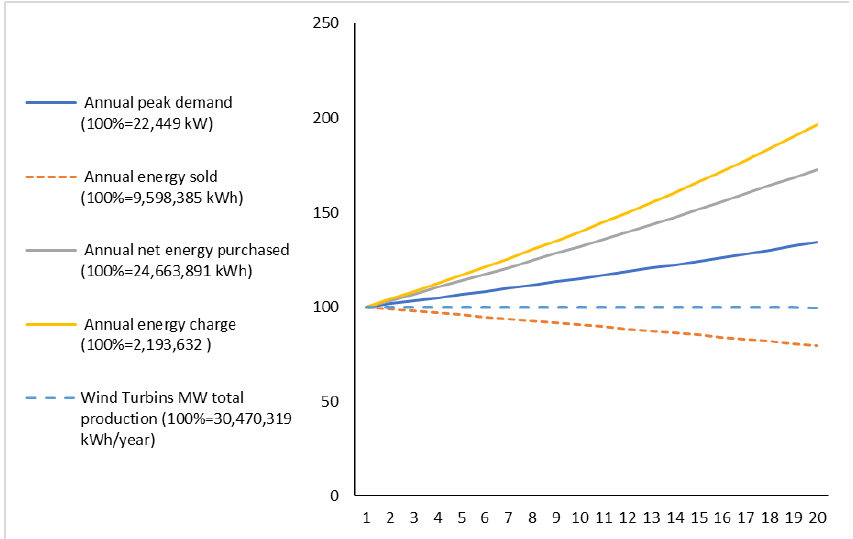
Figure 13. Multi-year module and the System performance.